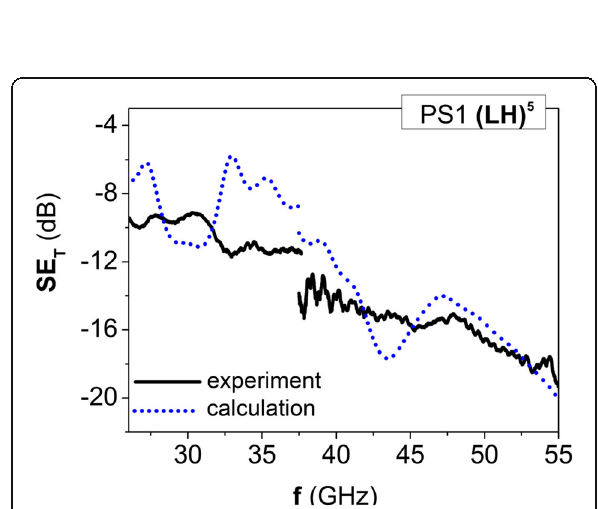
Fig. 4 EMR transmission spectra for 1D PS1 (LH) 5 , that consists of five epoxy L285 layers, which alter with composite layers 2 wt.%CNT/L285: solid lines correspond to experiment, dotted lines represent calculation at layers parameters listed in Tables 1 and 2 and tan δ ε 2 = − 0.098+0.0073